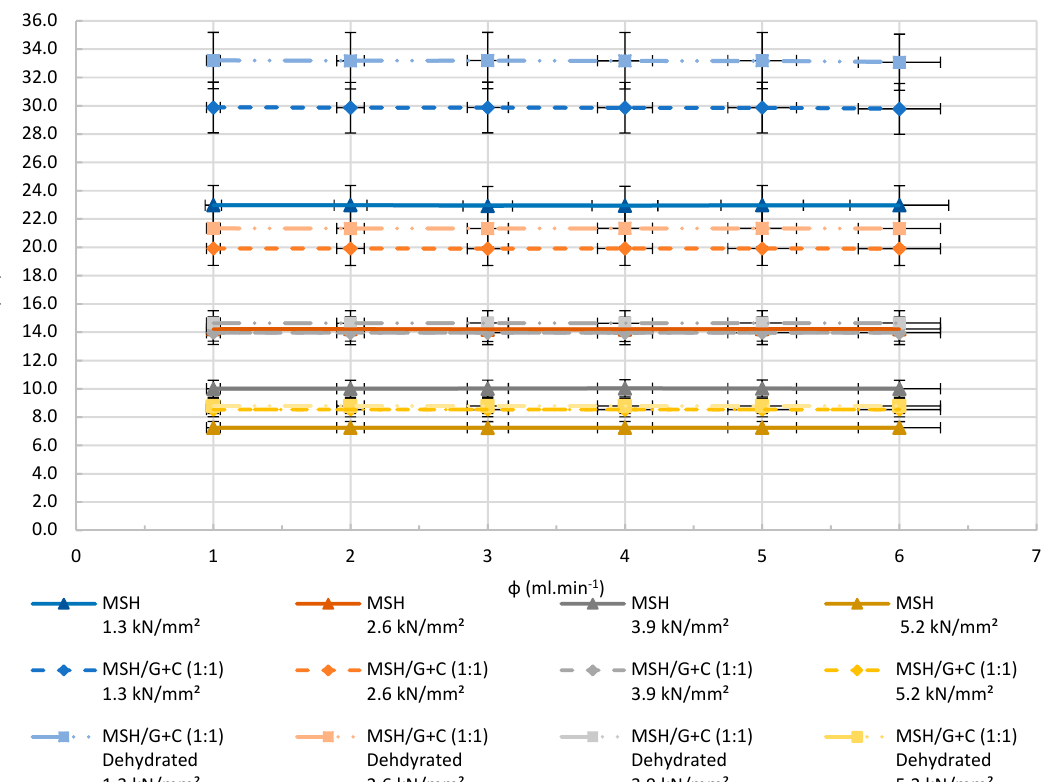
Figure 22. Experimental results of the permeability tests made for SBH ( top ) and MSH ( bottom ) pellets compressed in different pressures. R 2 > 0.99.